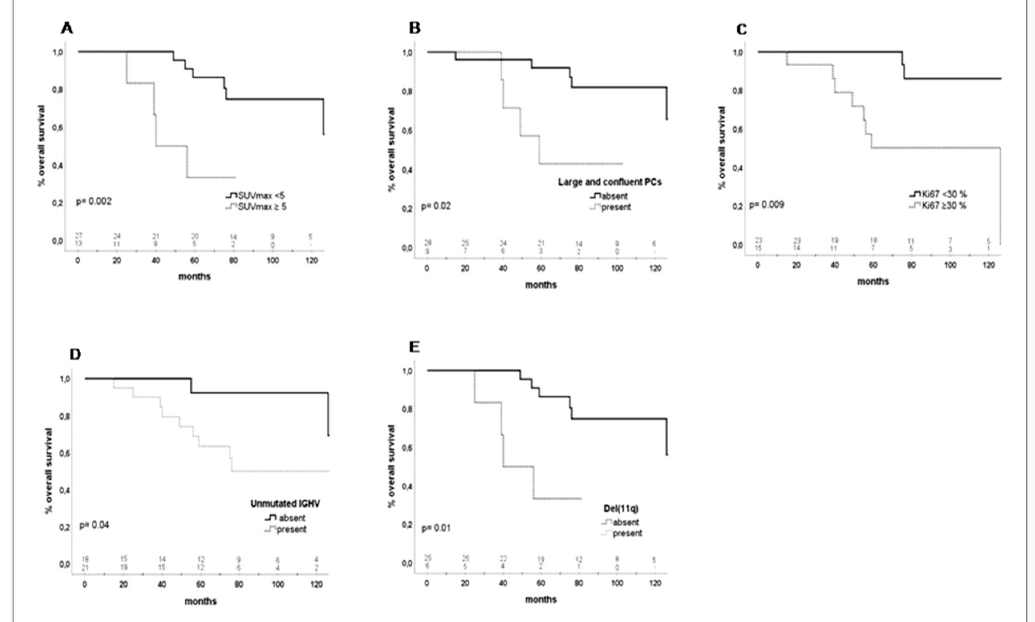
Figure 2. Overall survival (OS) of patients with biopsy-proven CLL. ( A ) Thirty-six-month OS according to the SUV max < 5, 100% vs. SUV max ≥ 5, 83% (95% CI: 64–102); p = 0.002. ( B ) Thirty-six-month OS according to the characteristics of proliferation centers (PCs): patients without large and confluent PCs, 96% (95% CI: 88.5–103.5) vs. with large and confluent PCs, 85% (95% CI: 89.3–110); p = 0.02. ( C ) Thirty-six-month OS according to Ki67% expression: Ki67% < 30, 100% vs. Ki67% ≥ 30, 93% (95% CI: 80.4–105.6); p = 0.009. ( D ) Thirty-six-month OS according to IGHV mutational status: IGHV mutated, 100% vs. IGHV unmutated, 90% (95% CI: 76.7–103.2), p = 0.04 ( E ) Thirty-six-month OS according to deletion (11q): patients without del(11q), 100% vs. patients with del(11q), 83% (95%CI: 53–113); p = 0.01.